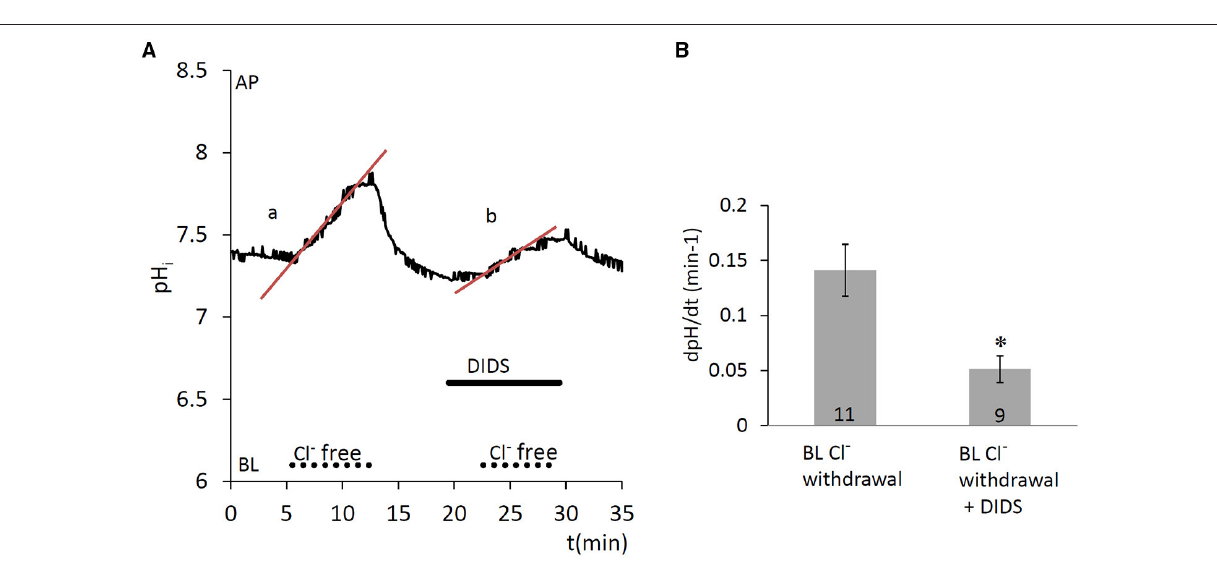
FIGURE 4 | Increase in pH i in HAT-7 cells upon Cl − withdrawal in the presence of HCO − 3 /CO 2 . (A) HAT-7 cells grown on Transwell membranes were exposed basolaterally to Cl − -free HCO − 3 -containing HEPES solution. An increase in pH i (a) can be seen, most probably as a result of HCO − 3 influx. Upon restoration of basolateral Cl − , pH i recovers to the baseline. Basolateral administration of DIDS (100 µ M) prior to a second Cl − withdrawal inhibited the increase in pH i (b) suggesting the presence of a HCO − 3 /Cl − exchanger. (B) Mean dpH/dt ( ± SEM) values were calculated from the initial rates of increase in pH i following removal Cl − in the presence and absence of the inhibitor ( n = 9–11). * p < 0.05 compared to